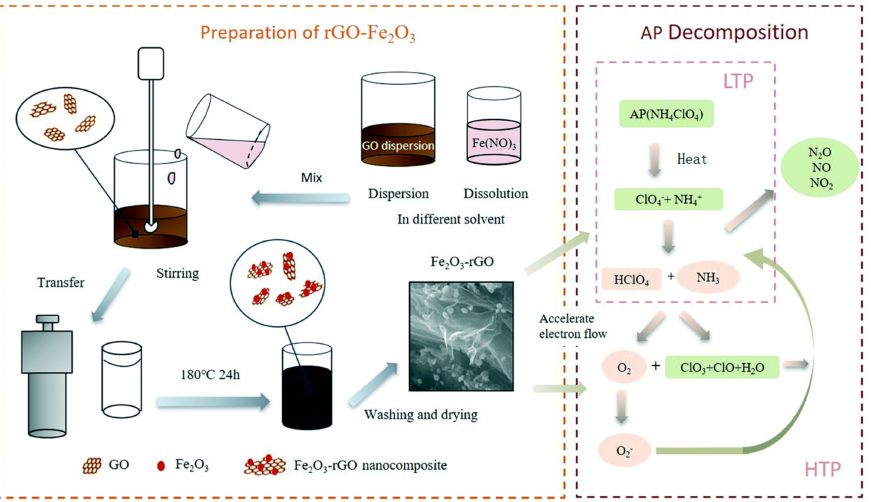
Figure 20. Illustration of Fe 2 O 3 /rGO fabrication and its catalytic mechanism for the thermal decom- position of AP. Reproduced with the permission of ref. [101]. Copyright 2018,